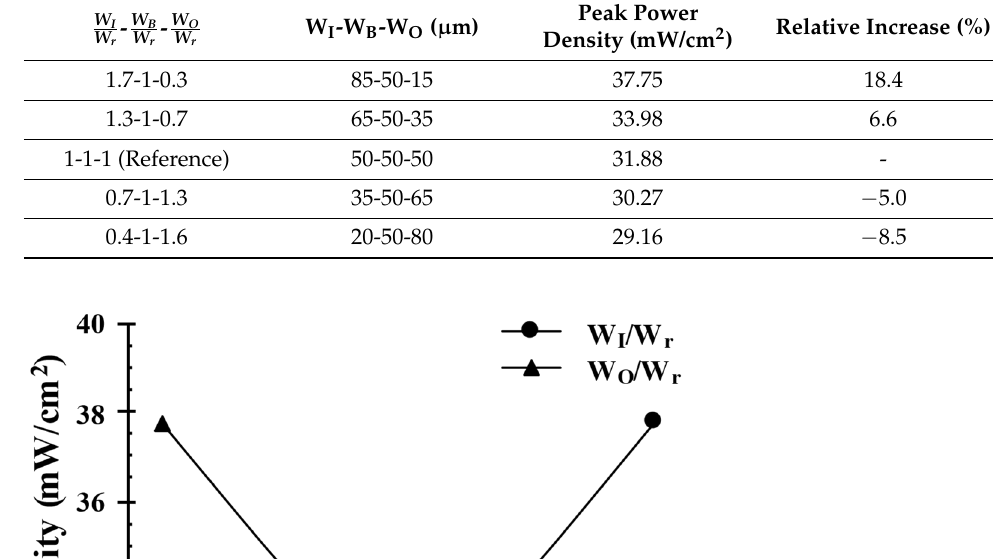
Table 2. Results of a previous parametric study [30] when W and W B were fixed (W B /W r = 1.0).